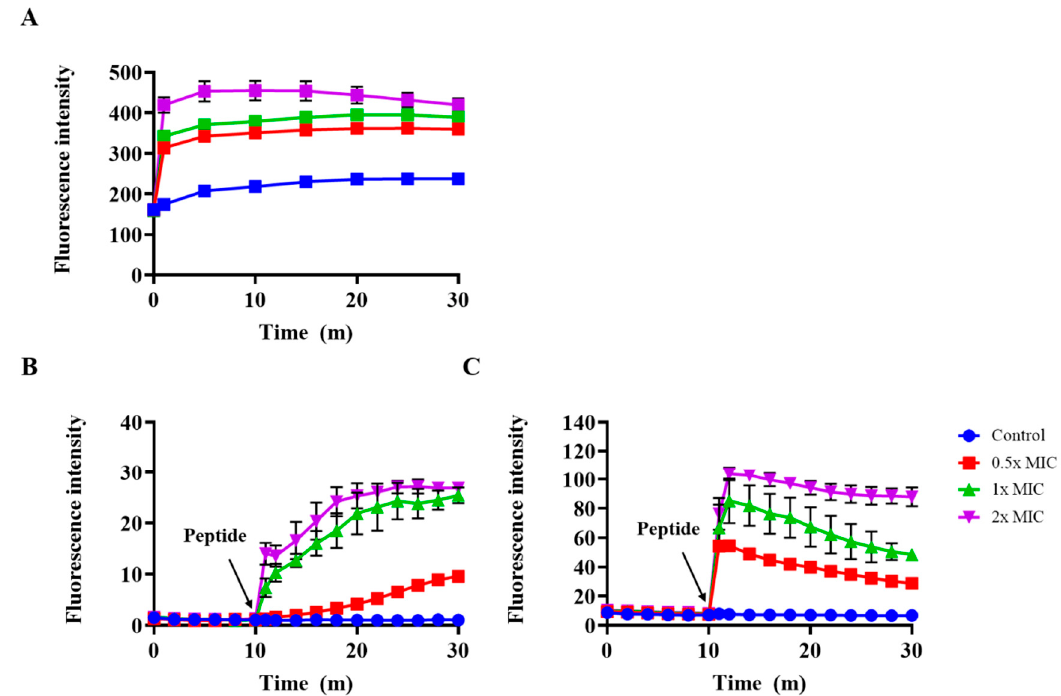
Figure 6. Outer membrane permeability and membrane depolarization assay. ( A ) S. typhimurium (ATCC 14028) outer membrane permeability induced by peptides. The outer membrane permeability of S. typhimurium induced by Css54 was measured using the fluorescent dye NPN ( N -phenyl-1-naphthylamine. ( B ) S. typhimurium and ( C ) L. monocytogenes cytoplasmic membrane depolarization assay. Bacterial cytoplasmic membrane depolarization was analyzed using the potential-sensitive dye DiSC 3 (5). Various concentrations of Css54 were added to the bacteria.